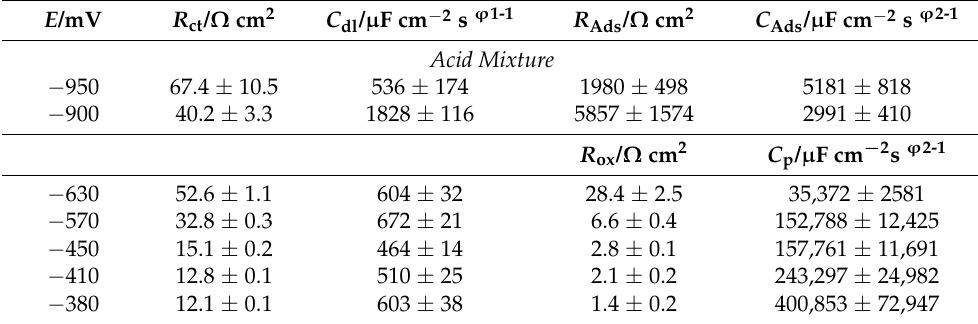
Table 1. Parameters for the processes of Fe electrode oxidation and azo dye electrodegradation (at a total concentration of AM at 50 mg dm − 3 ) on the surface of the Fe mild steel anode in contact with 0.054 M Na 2 SO 4 , achieved by fitting equivalent circuit models presented in Figure 5 to the experimentally obtained impedance data (dimensionless ϕ parameter, which determines the constant phase angle in the complex-plane plot (0 ≤ ϕ ≤ 1) of the CPEs circuit, varied between 0.79 and 0.86, and 0.50 and 0.96 for ϕ 1 and ϕ 2 ,